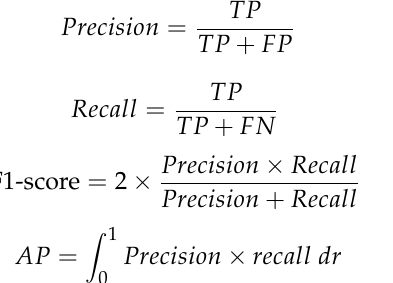
Configuration Parameter CPU Intel Xeon Gold 5220